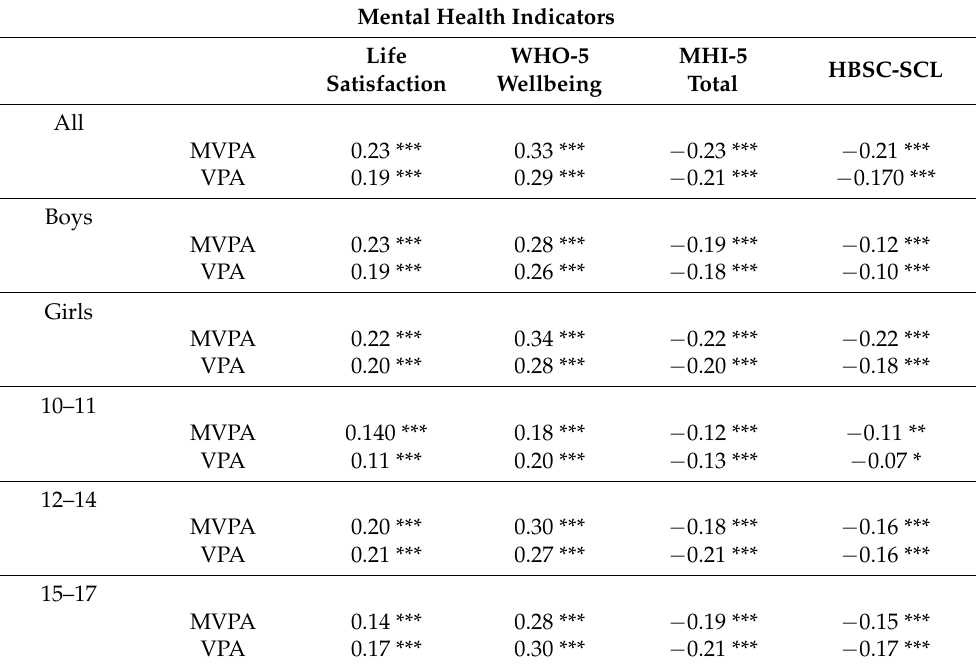
Table 3. Pearson correlation of physical activity and mental health by gender and age group.